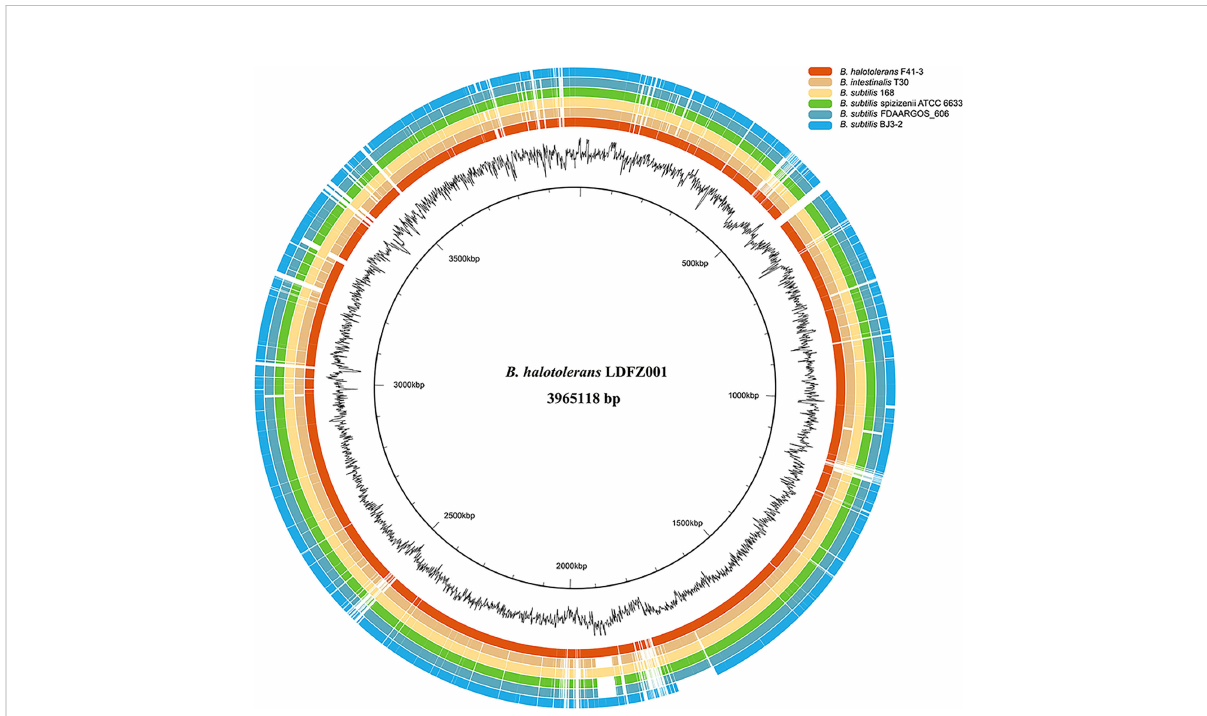
FIGURE 3 Genome comparison of B halotolerans LDFZ001 with six of its close Bacillus species. The innermost black circle represents the genome of B halotolerans LDFZ001 followed by its GC content and the Bacillus